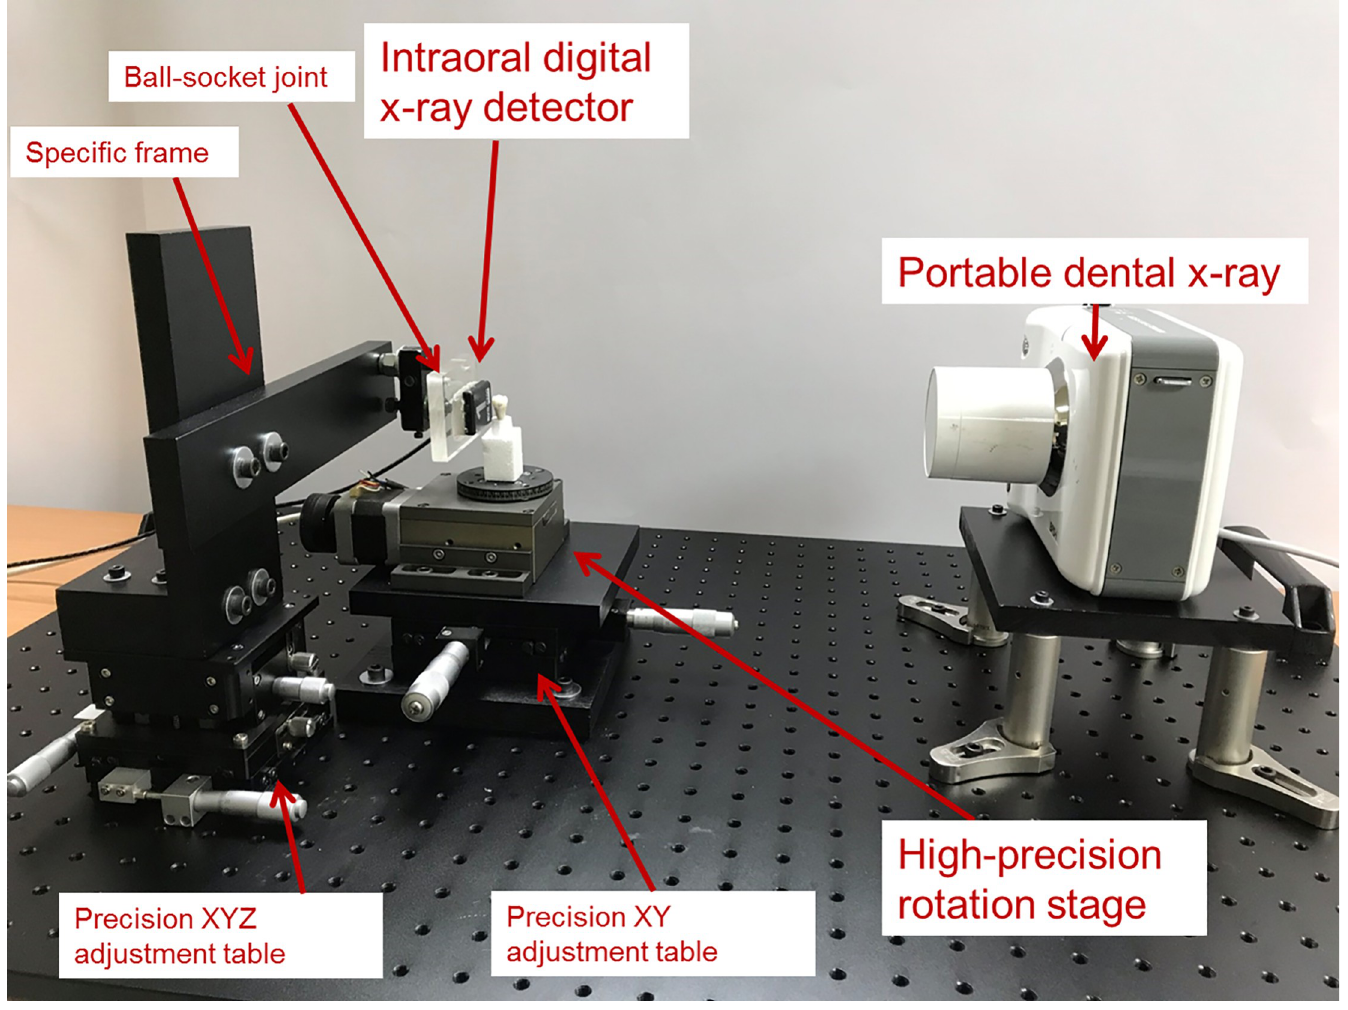
Fig 1. Main components of the experimental micro-CT